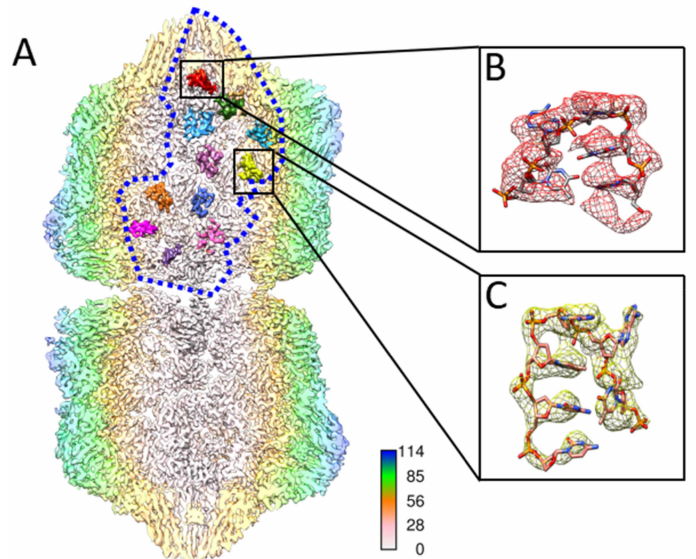
Figure 3. ssDNA densities in one asymmetric unit. ( A ) A total of 11 single-stranded DNA densities inside an asymmetric unit were separately colored in the rear half of TbCSV particle. The asymmetric unit is outlined by a blue dashed line. The TbCSV particle is presented as a longitudinal cross section, which is colored radially in the long axis. ( B , C ) Five and six nucleotides of DNA are modeled according to the density and zoomed in for